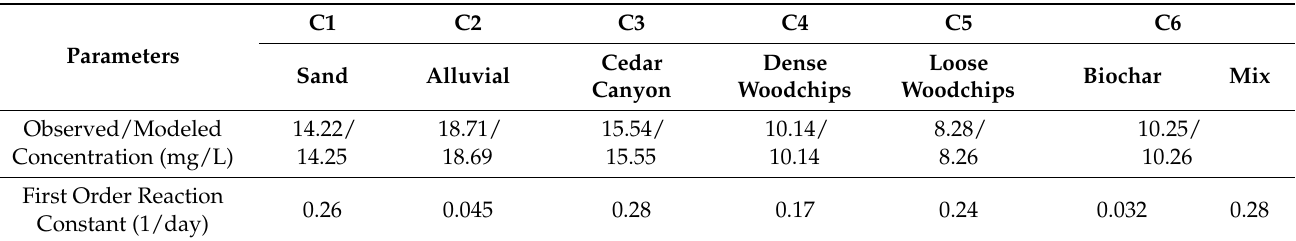
Table 3. Observed/Modeled Nitrate Solute